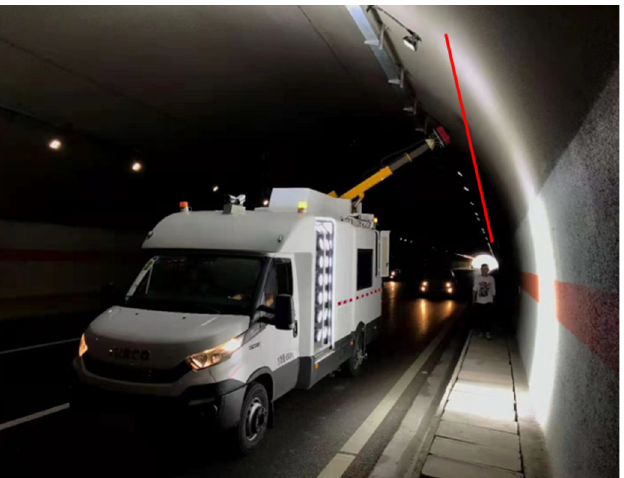
Figure 9. When the manipulator is adjusted to a reasonable attitude, start the vehicle to carry out a quick scan along the measurement line.